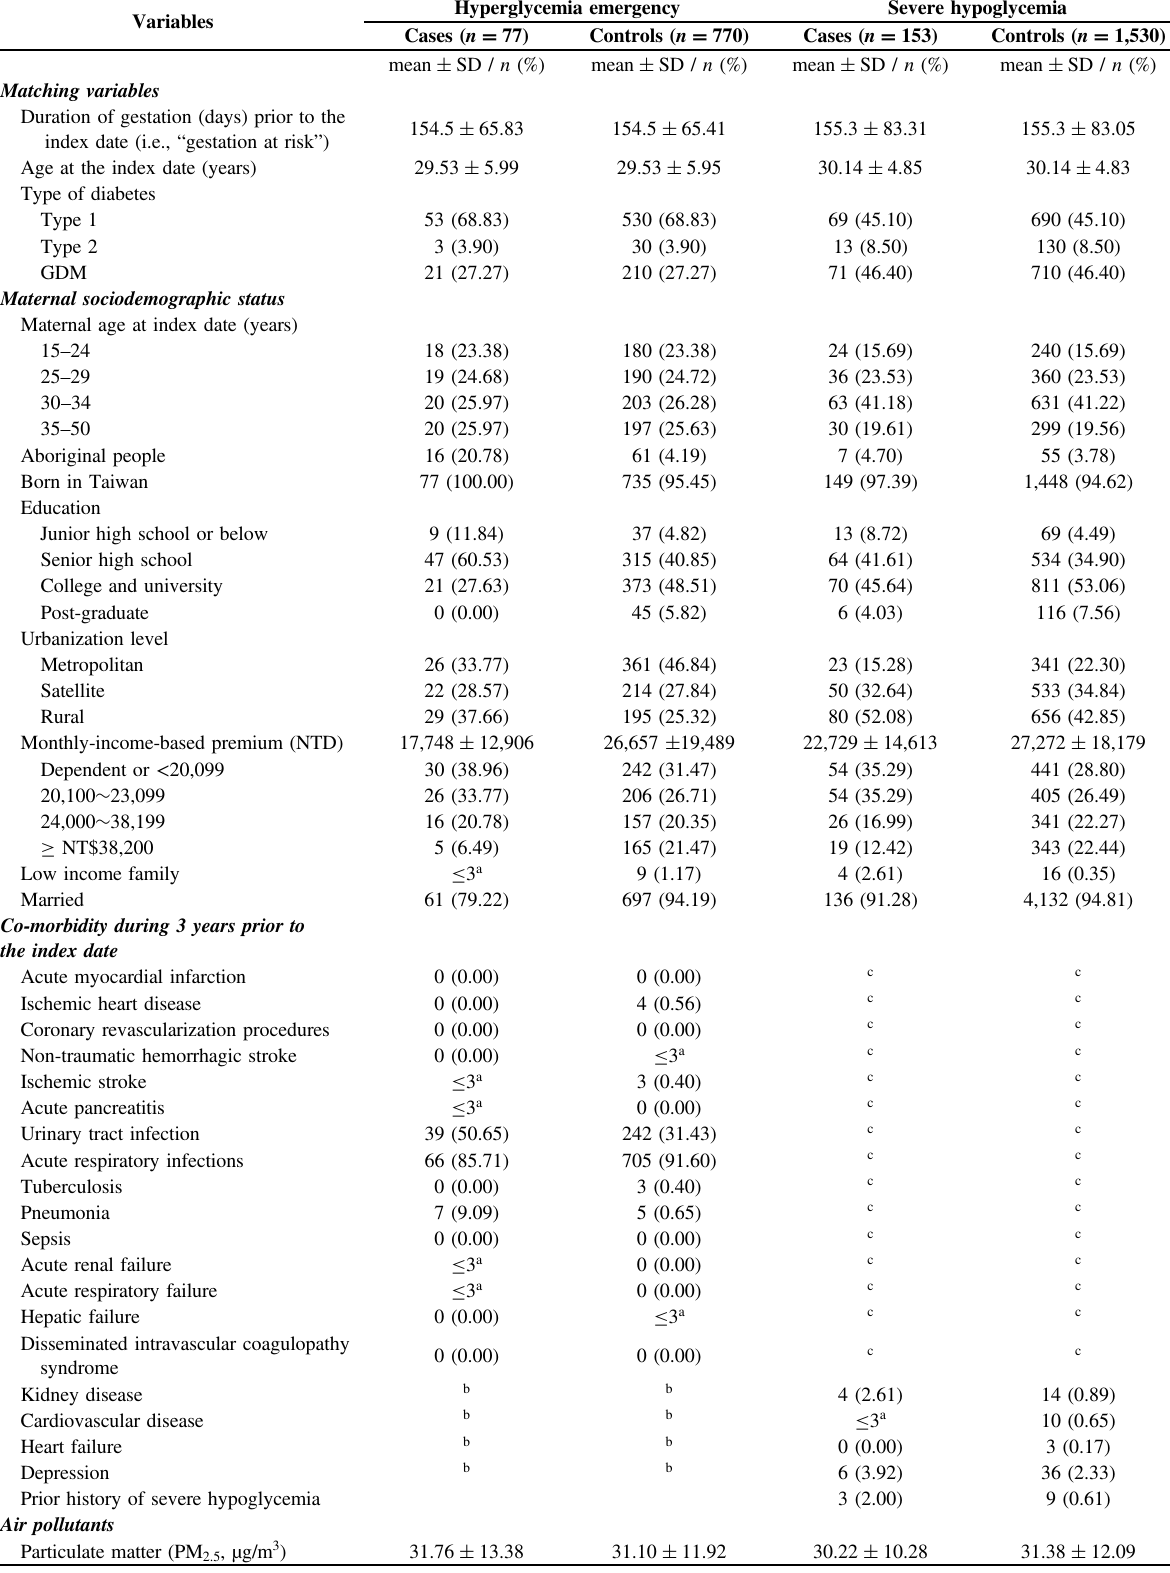
Table 1 Characteristics of study